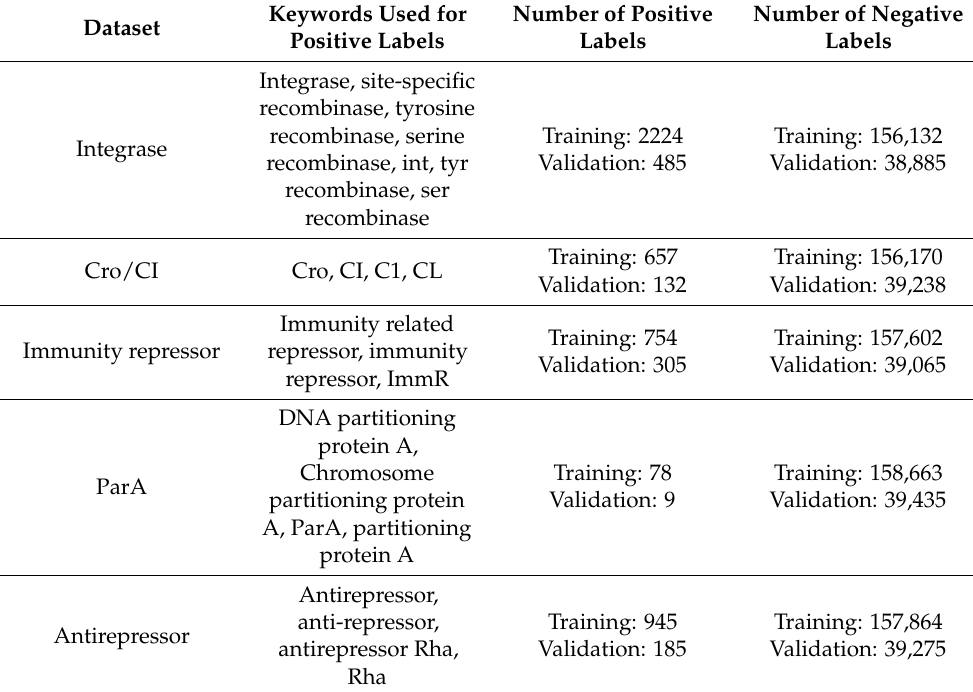
Table 1. Keywords used for labeling positive and negative data from annotated protein names and the resulting number of positive and negative labels in training and validation datasets.